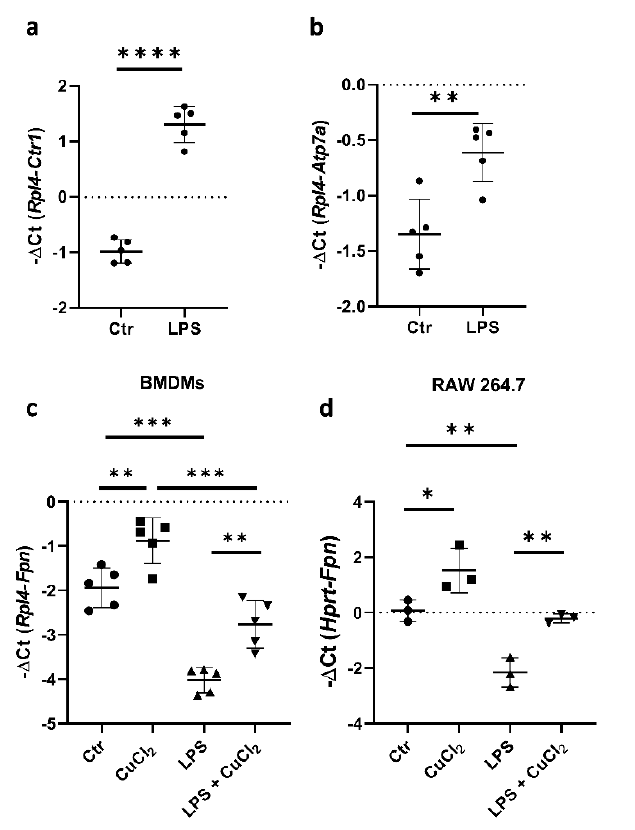
Figure 3. Copper loading counterweights LPS-induced suppression of Fpn mRNA. ( a , b ) qPCR analysis of Ctr1 and Atp7a mRNA expression in BMDMs incubated with 100 ng/mL lipopolysaccharide (LPS) for 16 h. Data represent mean ± SD, ** p < 0.01, **** p < 0.0001. qPCR analysis of Fpn mRNA expression in ( c ) BMDMs and ( d ) RAW 264.7 macrophages treated with 100 or 200 ng/mL LPS, respectively, in the absence or presence of 150 μ M CuCl 2 for 16 h. Data represent mean ± SD, * p < 0.05, ** p < 0.01, *** p < 0.001.